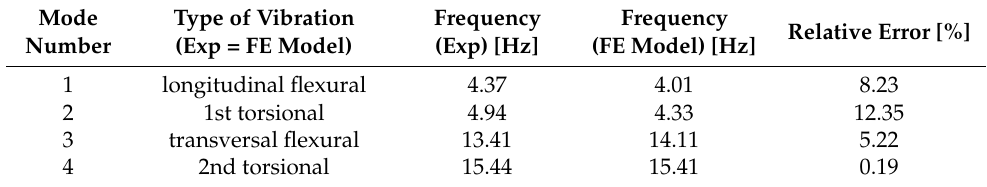
Table 3. Comparison between experimental and numerical natural frequencies of the bridge